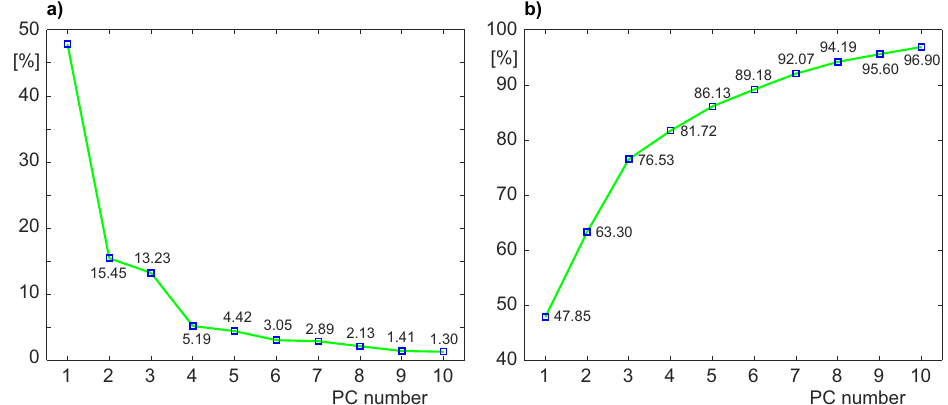
Figure 9. Explanation of the selection of the principal components which create the MPCA model: ( a ) Scree plot—percent of variance captured by the first 10 principal components. ( b ) Accumulated contribution rate cr m for the first 10 principal components.